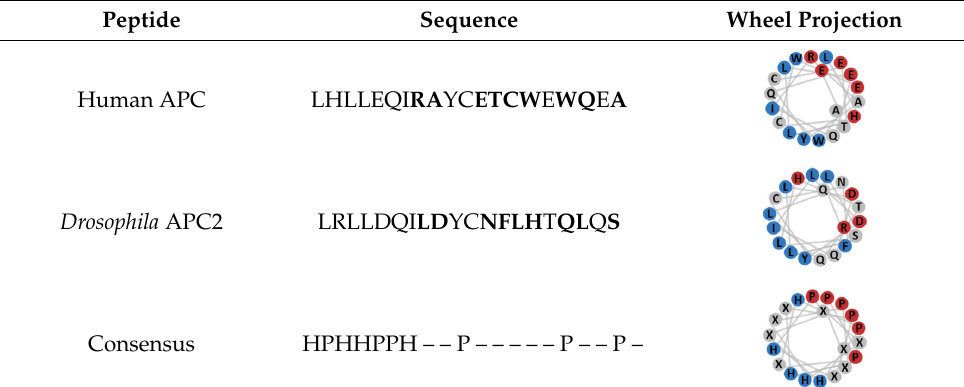
Table 2. A comparison between Human APC and Drosophila APC2 *.